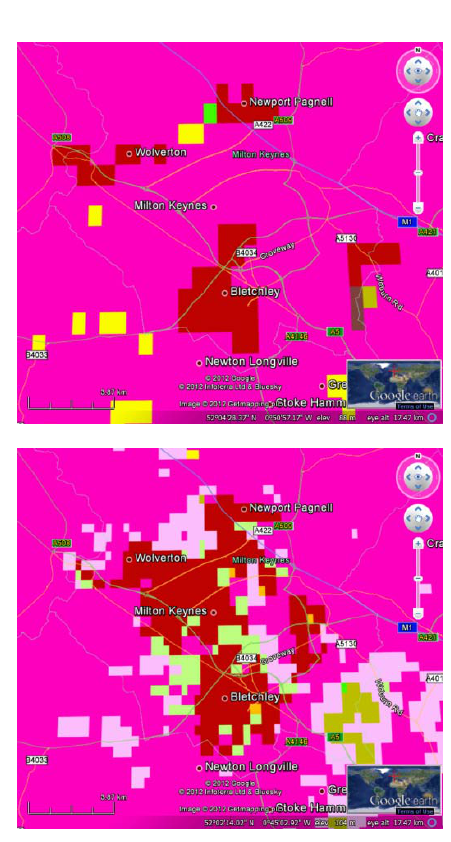
Figure 42: MODIS (top) and GLC-2000 (bottom) satellite images covering a 20km x 20km area around the UK town of Milton Keynes, showing automatic classification by different but standard approaches, to indicate similar land cover classes. In both images deep pink is cropland or natural vegetation, red is urban and built up